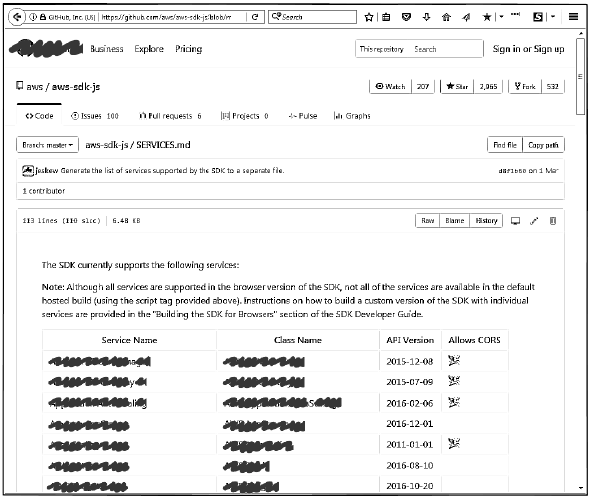
Fig. 17. Source-code repository for Node.js SDK with a note stating that some services may be missing.